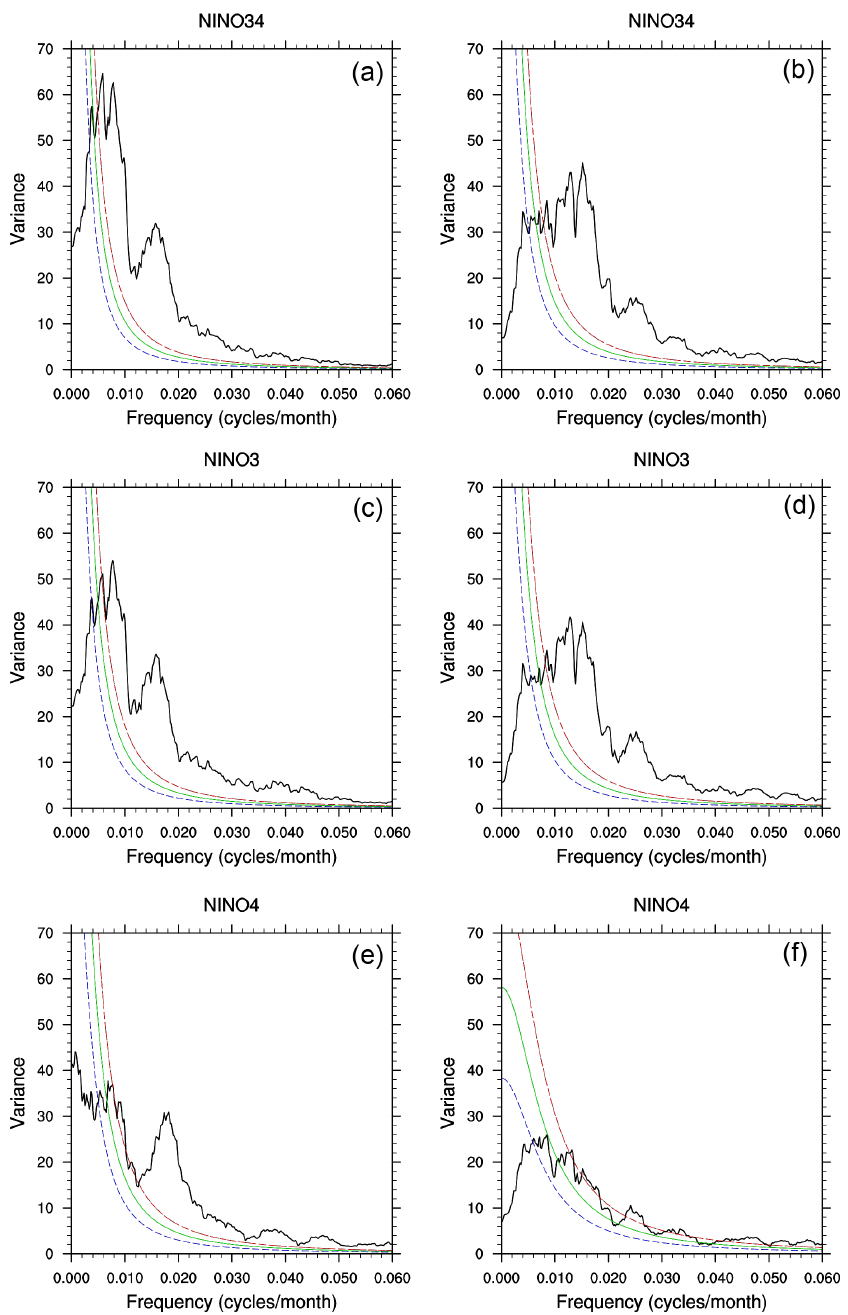
Figure 3. Multi-taper power spectrum of NIÑO3, NIÑO34, and NIÑO4. Panels (a) , (c) , and (e) show the power spectrum for the CTR simulation. Panels (b) , (d) , and (f) are the same as (a) , (c) , and (e) but for the MIS31 simulation. Red, green, and blue lines show the 99%, 95%, and 90% significance levels,